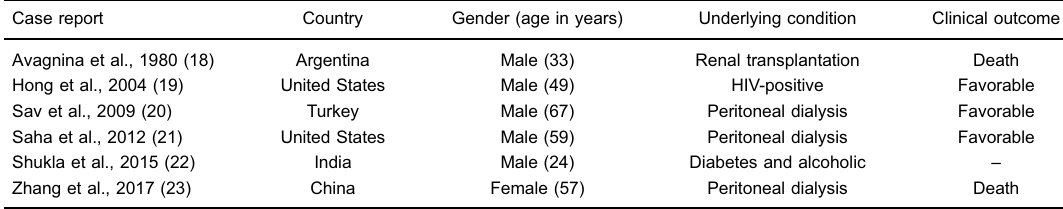
Table 1. Literature data concerning the fi nding of Strongyloides stercoralis in peritoneal fl uid. Case